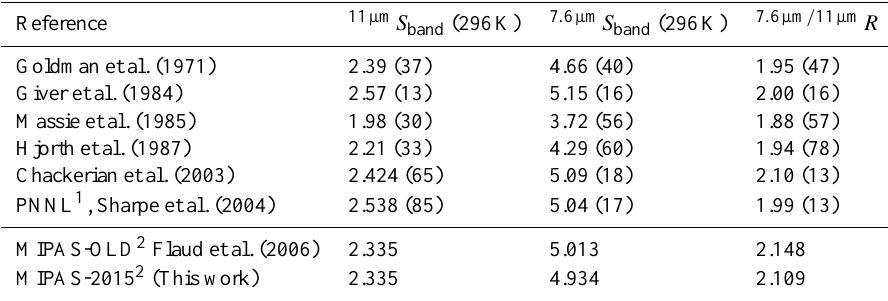
Table 5. Comparison of measured and calculated HNO 3 integrated band intensities in the 11µm (820–950cm − 1 ) and 7.6µm (1240– 1400cm − 1 ) spectral ranges.